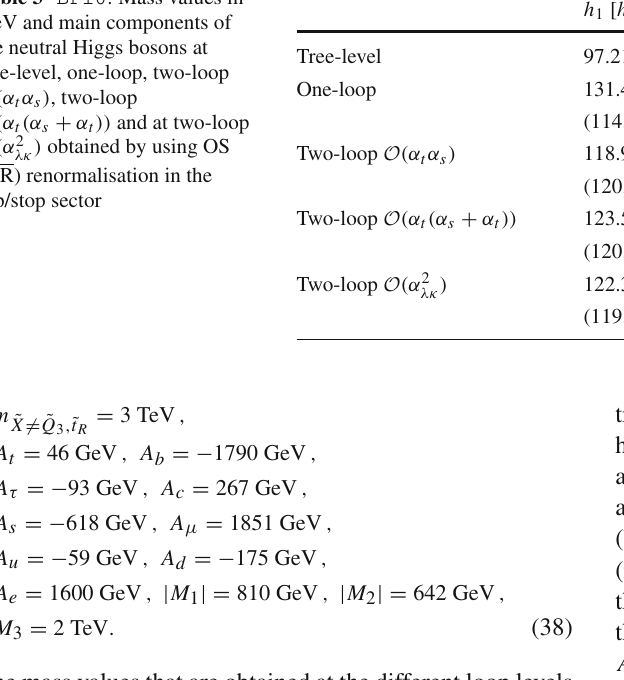
Table 3 BP10 : Mass values in GeV and main components of the neutral Higgs bosons at tree-level, one-loop, two-loop α ) , two-loop O (α t s (α + α )) and at two-loop O (α t s t O (α 2 (DR) renormalisation in the top/stop